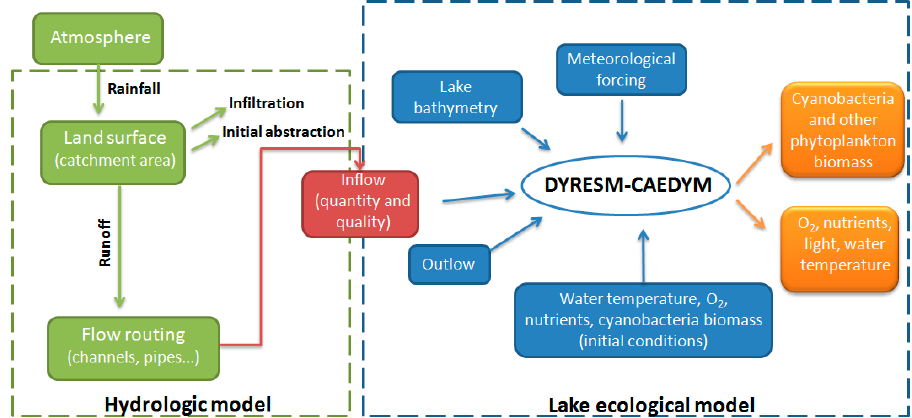
Figure 2. Integrated modelling approach diagram.